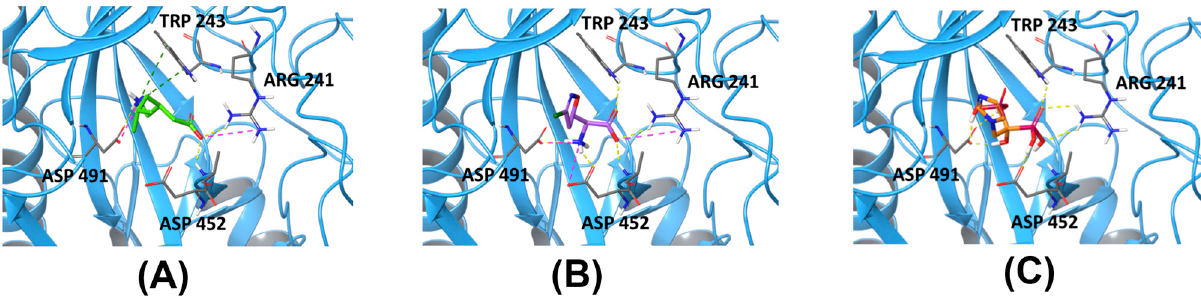
Figure 2. The overlay of the binding pose of PRG (green) and zoledronic acid (gold).